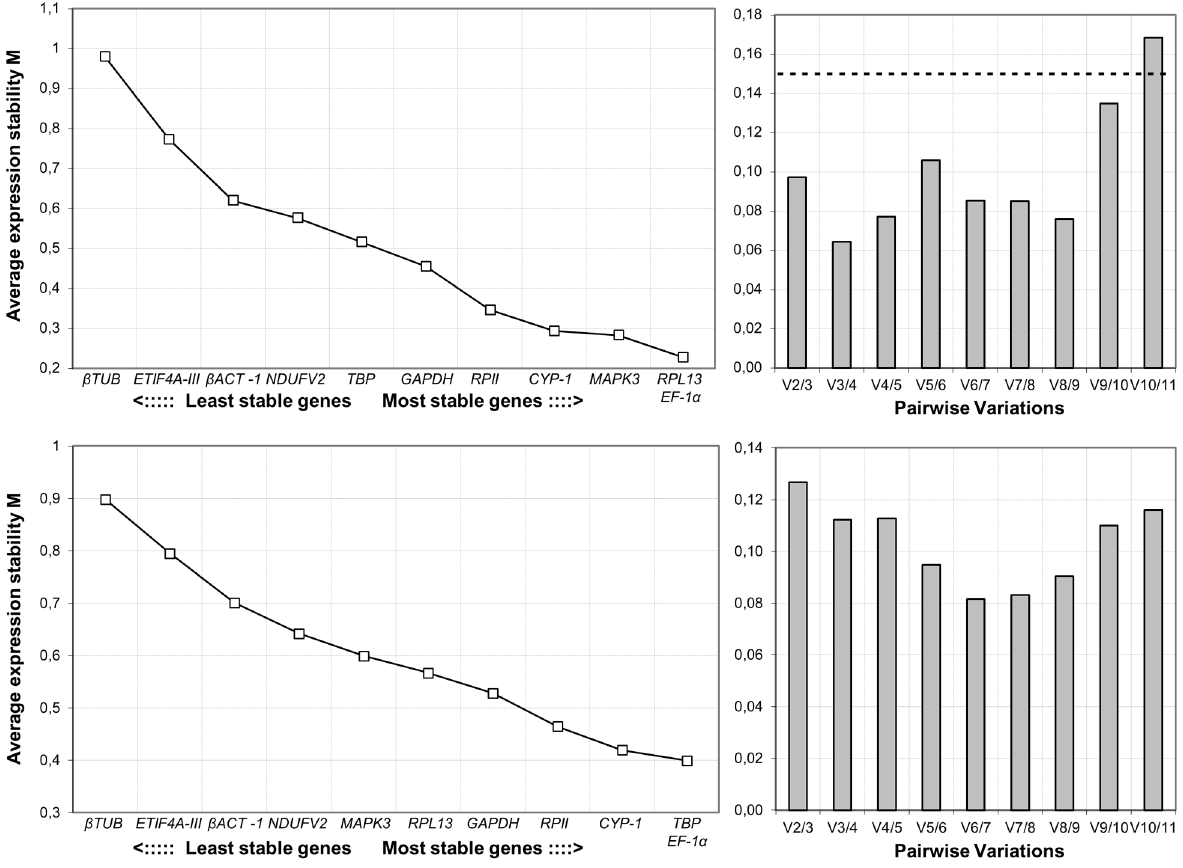
Figure 2. Gene expression stability (left) and determination of the optimal number of reference genes (right) by geNorm. The top charts correspond to E. granulosus s.s. (G1), and the bottom charts correspond to E. ortleppi . The dotted line represents the cut-off of 0.15 proposed by geNorm authors to determine the optimal number of reference genes to be used.